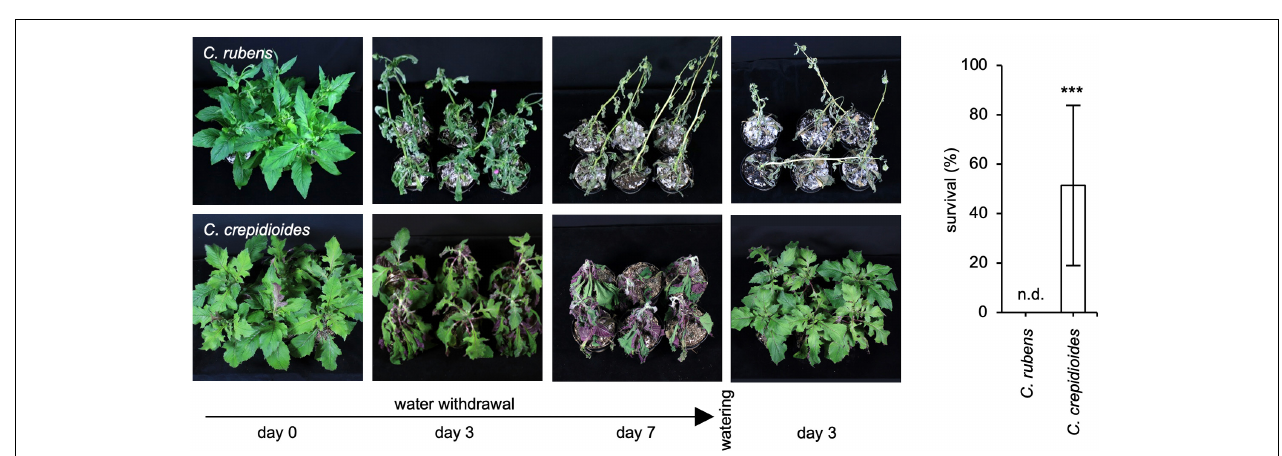
FIGURE 6 | Crassocephalum crepidioides shows a higher recovery potential following drought than C. rubens. Seven-week-old plants of C. rubens Mali and 8-week-old plants of C. crepidioides Ile-Ife, grown in 16-h white light/8-h dark cycles at 25 ◦ C, were subjected to progressive drought by withholding water for 7 days before they were re-watered. Left: Photos of representative plants, taken at the indicated time-points. Right: Survival rates, which are defined as the ability to form new leaves. The mean and SD of three biological replicates, with at least 12 individual plants each, are shown. The asterisk indicates significant differences between genotypes by Student’s t -test (*** p ≤ 0.001); n.d.: not